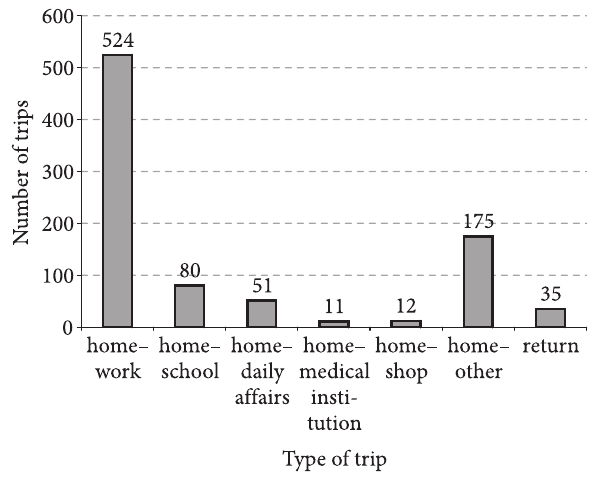
fig. 6. Travel purposes of people crossing or entering Vilnius Old Town